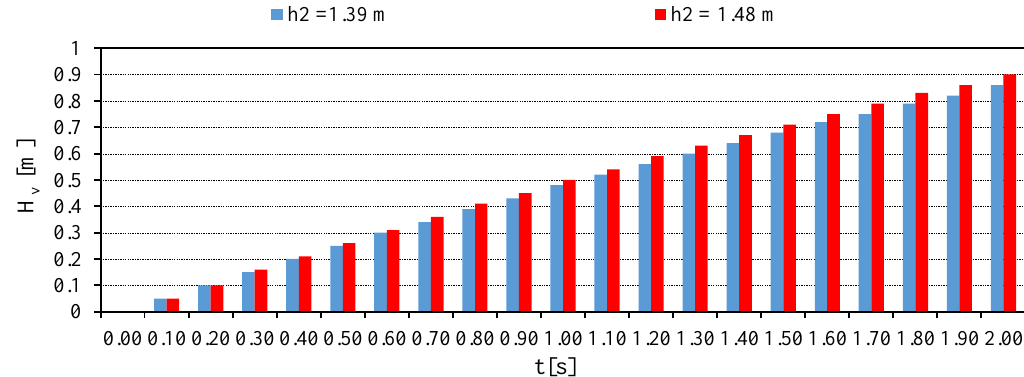
Figure 12. Visible vehicle body height H v in function of time t (design speed V = 100 km/h).